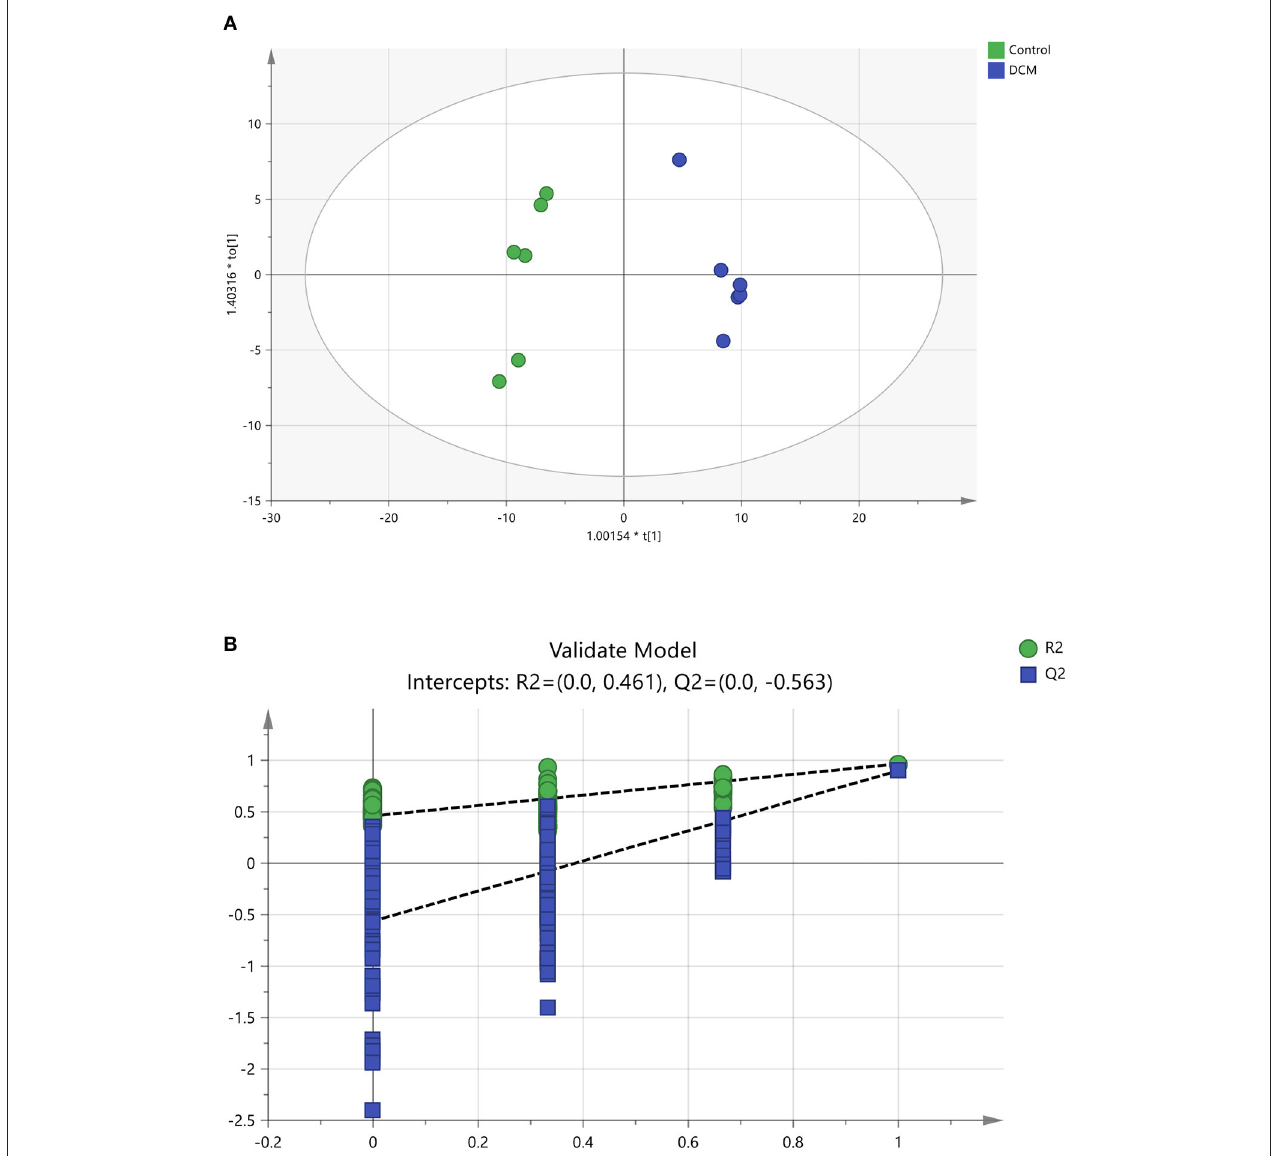
FIGURE 7 | The OPLS-DA scores scatter plot and validation plot. (A) The orthogonal projection to latent structures discriminant analysis (OPLS-DA) scores scatter plot obtained from the diabetic cardiomyopathy (DCM) group vs. control group. (B) Validation plot for OPLS-DA model. The permutation test was conducted for 200 times to evaluate the risk of over-fitting for the OPLS-DA model. DCM, diabetic cardiomyopathy. (A) , Control, , DCM model group; (B) , R 2 , , Q 2